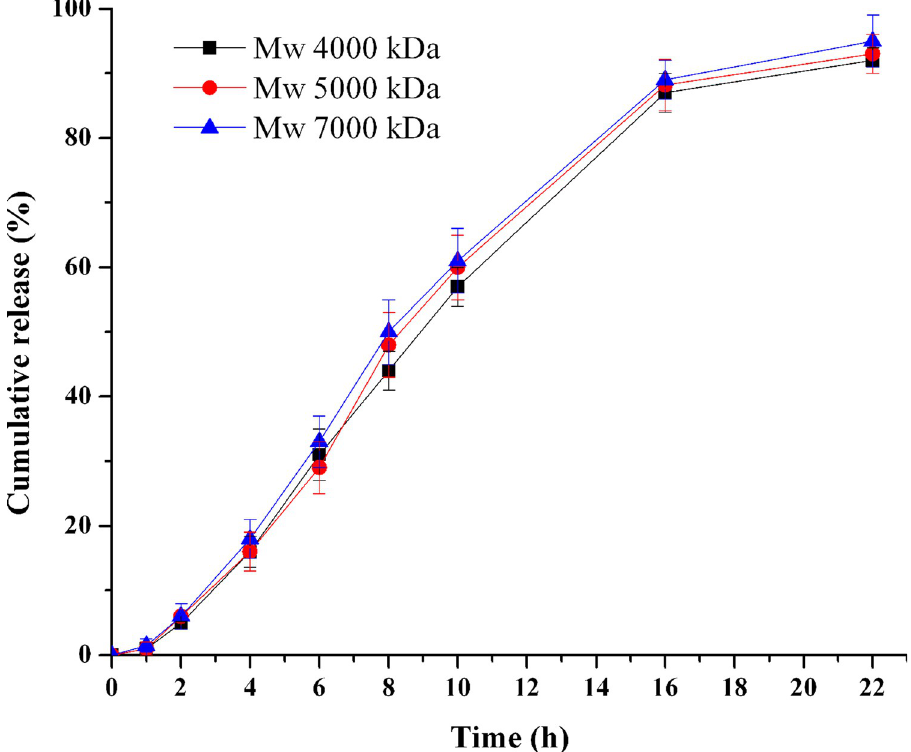
Fig 6. Effect of PEO molecular weight in push layer on TPM release (n =